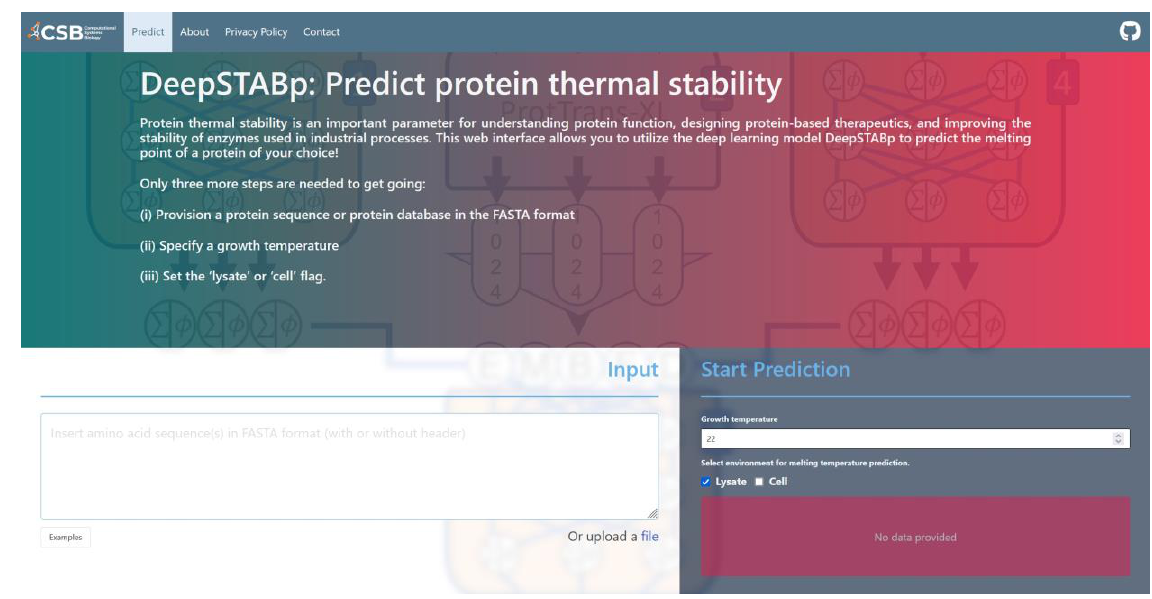
Figure 6. Screen capture of the web-interface of DeepSTABp. The screenshot shows how the Deep- STABp model can be accessed via a user-friendly web interface. After provisioning of input param- eters, researchers are provided with predicted protein melting temperatures.